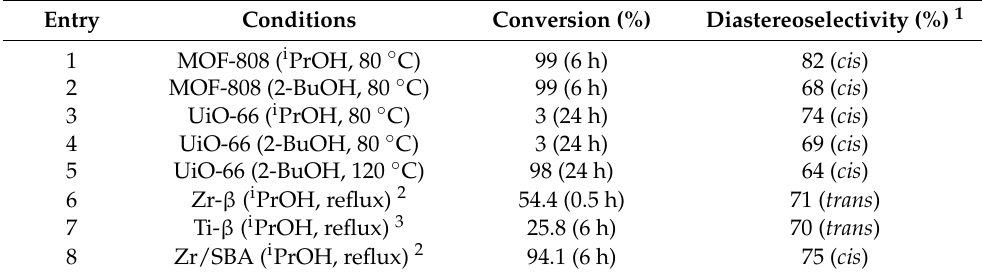
Table 1. MPV reaction of 3MeCH = O over various heterogeneous catalysts.